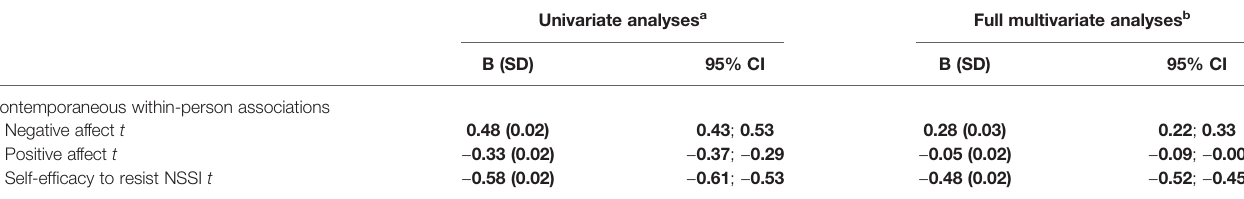
TABLE 3 | Contemporaneous (moment-to-moment) associations between affective states, self-ef fi cacy to resist NSSI, and non-suicidal self-injurious